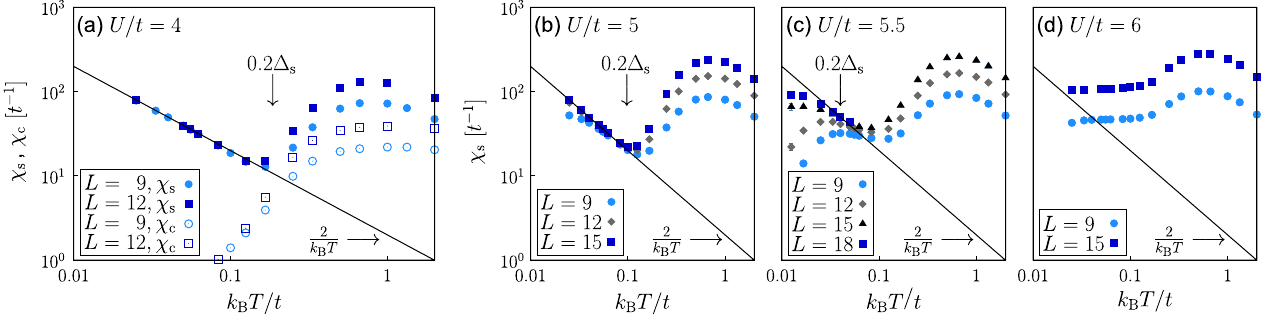
FIG. 6. (a) Spin ( (cid:9) ) and charge ( (cid:9) ) susceptibilities of the Kane-Mele-Hubbard model ( (cid:4)=t ¼ 0 : 2 , (cid:5) ¼ 0 ) at U=t ¼ 4 . We consider s c L (cid:4) L lattices with one pair of (cid:1) fluxes placed at the maximal distance. At low temperatures, the spin susceptibility reveals a Curie law ¼ 2 (cid:9) , whereas the charge susceptibility is suppressed by the charge gap. (b), (c) Spin susceptibility as a function of temperature for s k B T different values of U=t ( (cid:4)=t ¼ 0 : 2 , (cid:5) ¼ 0 ). (a)–(c) show that with increasing U=t , the range of the interaction between spin fluxons ¼ 2 ¼ 5 : 70 ð 3 Þ t , (cid:9) at low temperatures. (d) For U > U reflects the presence increases, leading to deviations from the Curie law (cid:9) s c s k B T of long-range magnetic order in the bulk. Error bars are smaller than the symbol size. The arrows indicate the energy scale associated with the spin